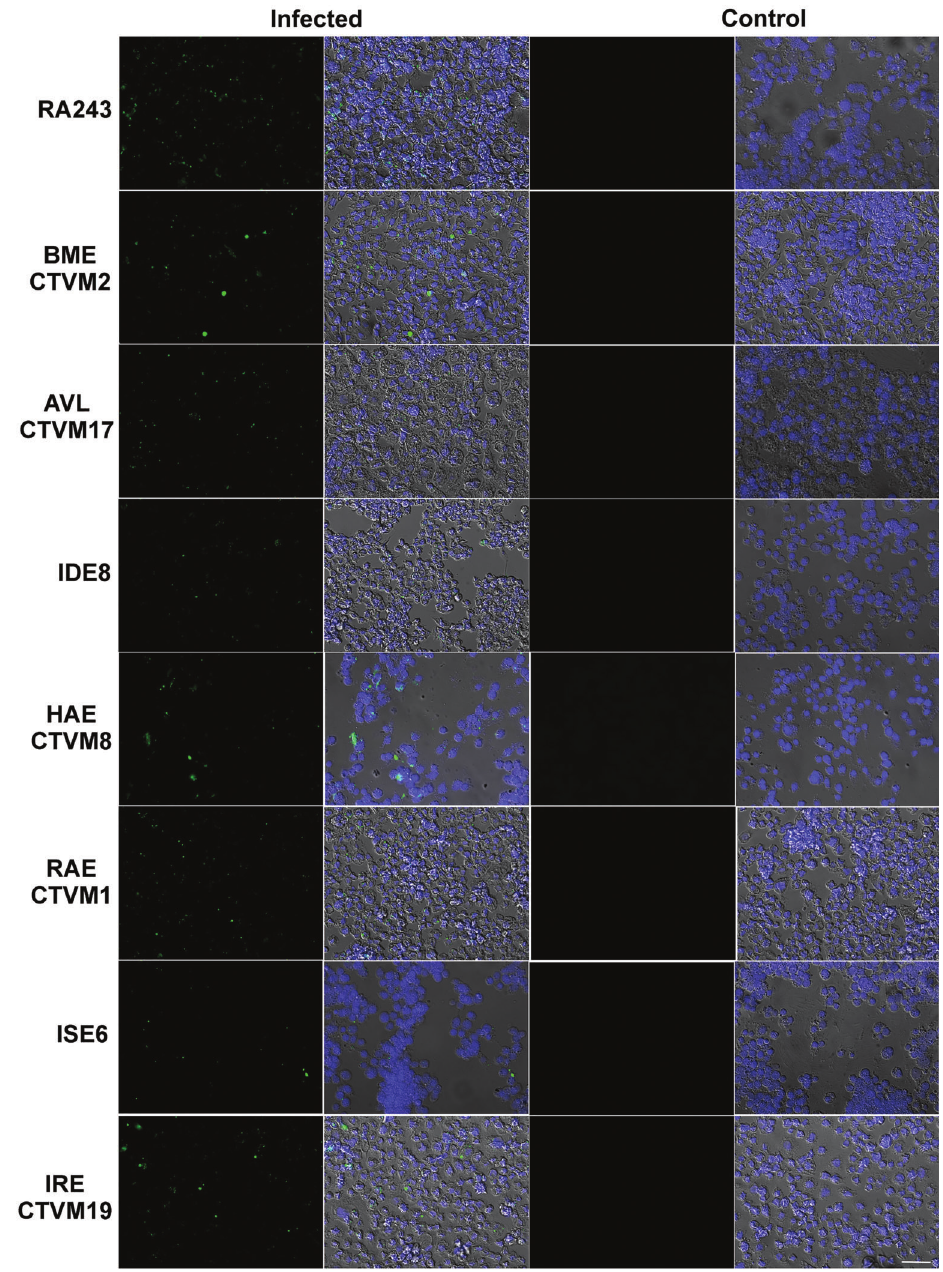
Figure 3. Tick cell lines RA243, BME/CTVM2, AVL/CTVM17, IDE8, HAE/CTVM8, RAE/CTVM1, ISE6 and IRE/CTVM19 inoculated with Borrelia burgdorferi previously stained with PKH67 and uninfected control cells after 24 h in 10% BSK-H + 90% cell medium. In the second and fourth columns, nuclei were stained with DAPI. The scale bar represents 50 m